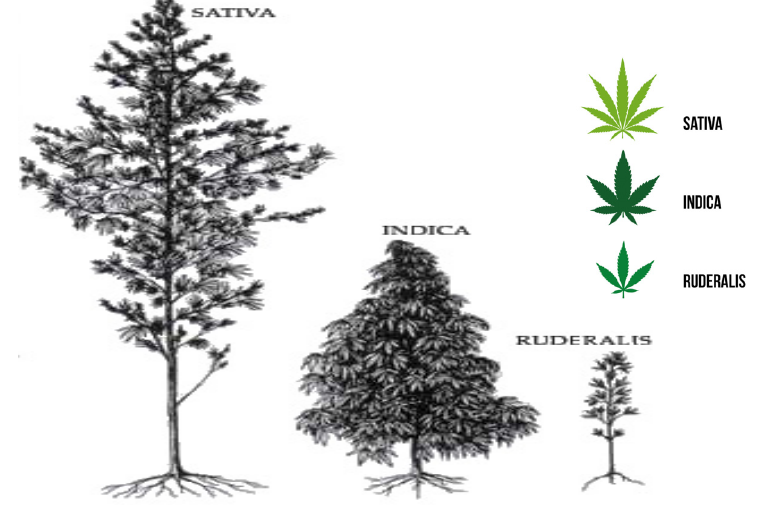
Figure 1. Cannabis plant [1].